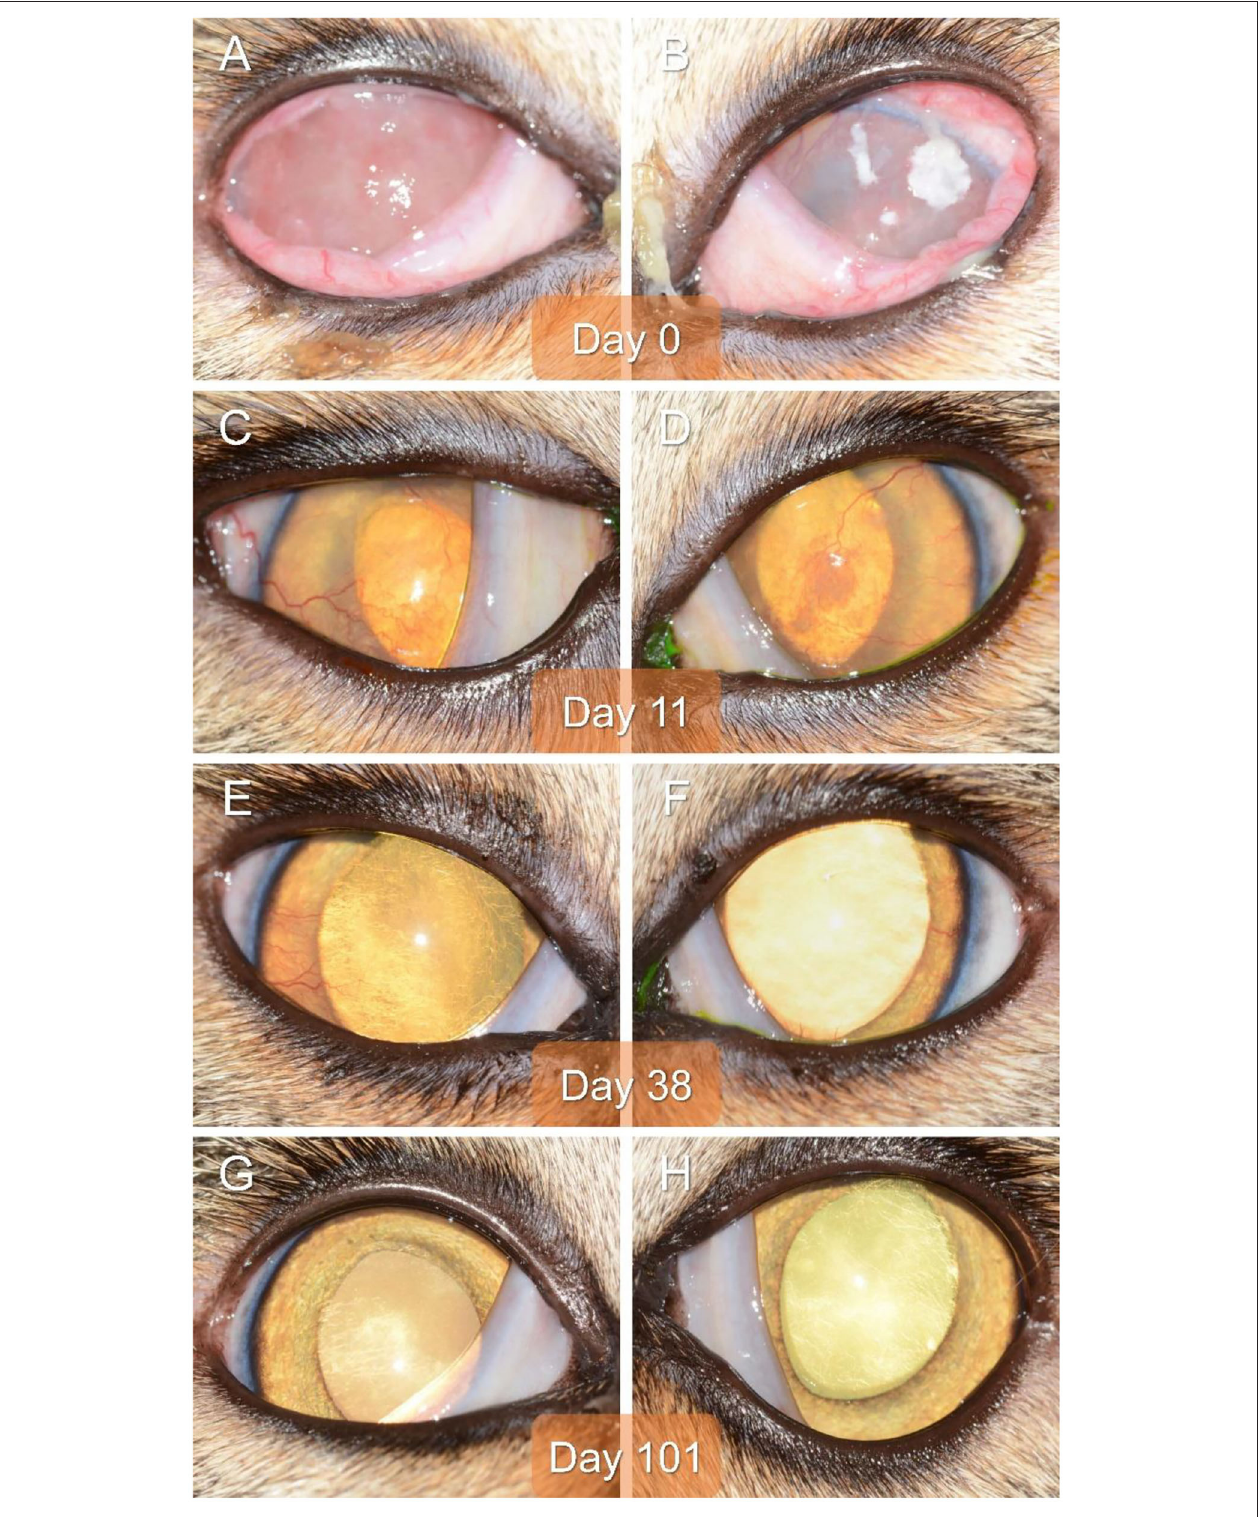
FIGURE 1 | Clinical images of the right eye (A,C,E,G) and left eye (B,D,F,H) of a 2-year-old domestic shorthair cat diagnosed with severe bilateral eosinophilic keratitis, managed with combined immunosuppressive therapy (subcutaneous triamcinolone acetonide and topical 0.5% tacrolimus), and examined on Day 0 (A,B) , Day 11 (C,D) , Day 38 (E,F) , and Day 101 (G,H) .